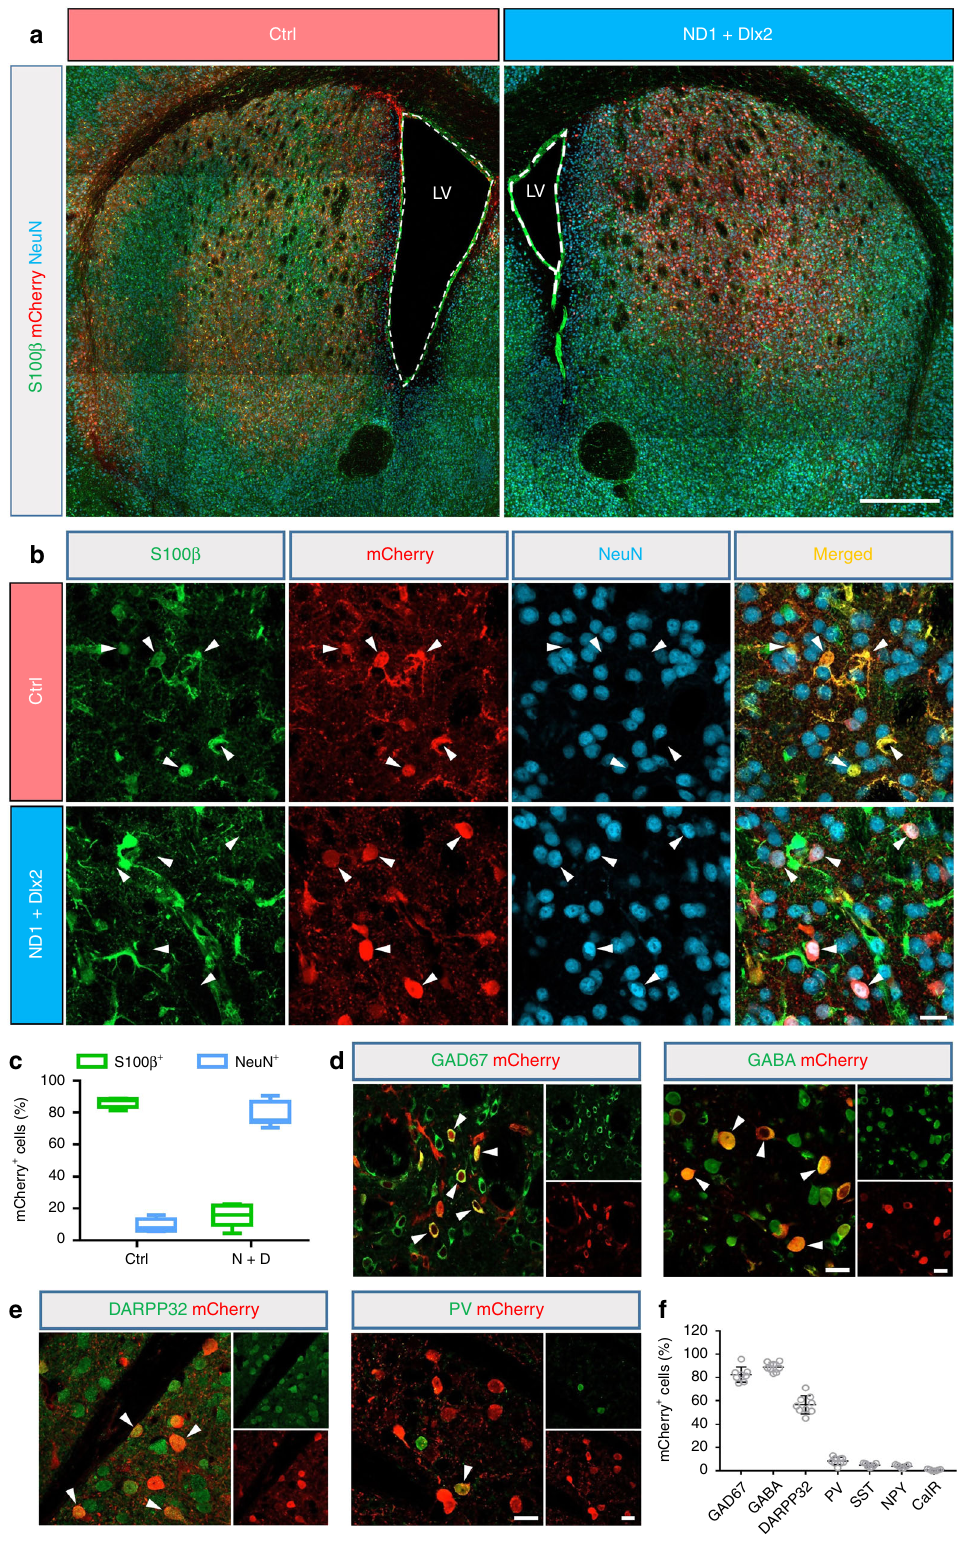
Axonal projections of the astrocyte-converted neurons . Striatal MSNs send axonal projections to two distinct nuclei within the basal ganglia, the external globus pallidus (GP) and the substantia nigra pars reticulata (SNr). Due to the severe loss of MSNs in the striatum, these two output pathways are severely disrupted in the